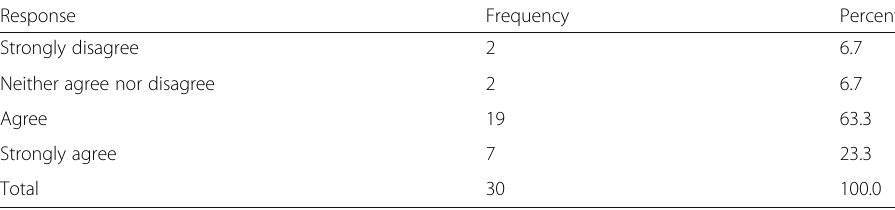
Table 1 There is high congestion at the sea ports Response Frequency Percent Strongly disagree 2 6.7 Neither agree nor disagree 2 6.7 Agree 19 63.3 Strongly agree 7 23.3 Total 30 100.0